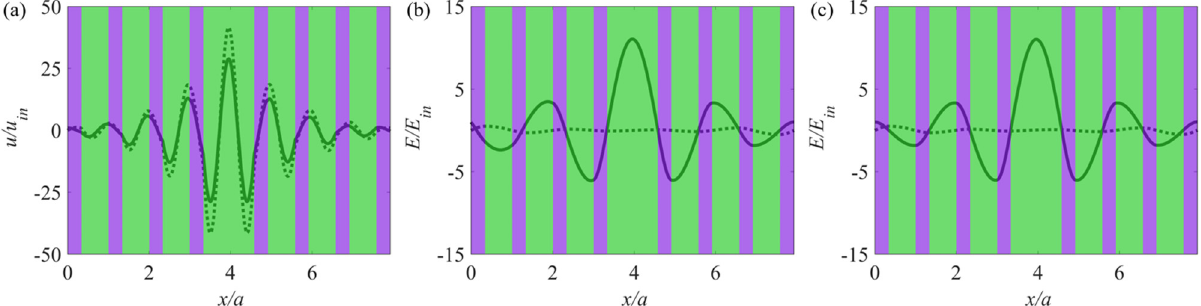
Figure 5: ( a ) Displacement fi eld distribution of the defect PNC mode Ω a c ′